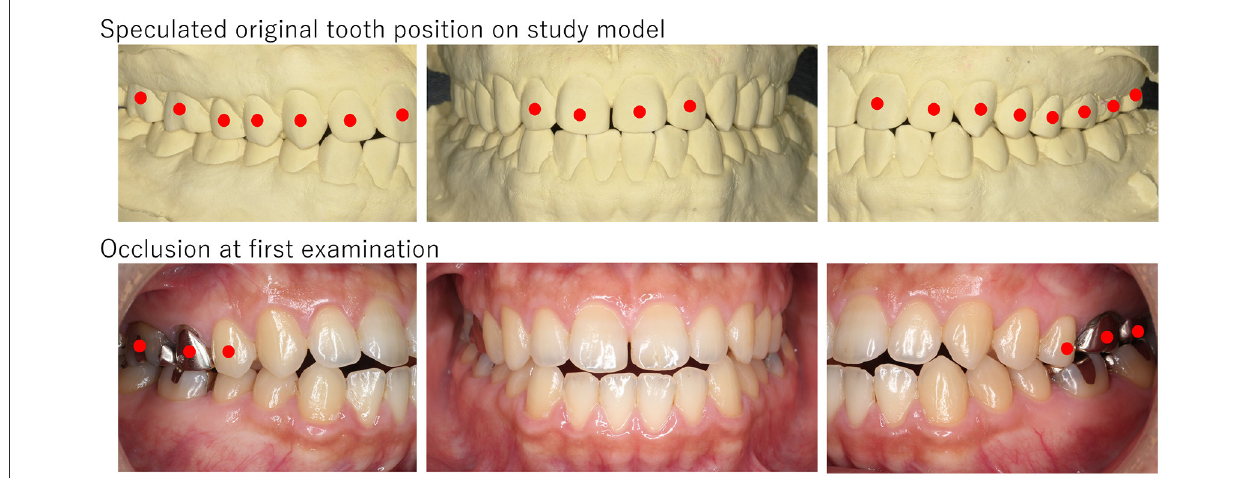
FIGURE1 The picture of a patient (Case No. 1). Slight open bite was observed with no occlusal contact from the right canine to the left one. Since facets were observed on both sides of the canine and incisal edges and his study model showed tight occlusion, his mandibular had potentially shifted anteroinferior. Red circles indicate teeth that have occlusal contact.